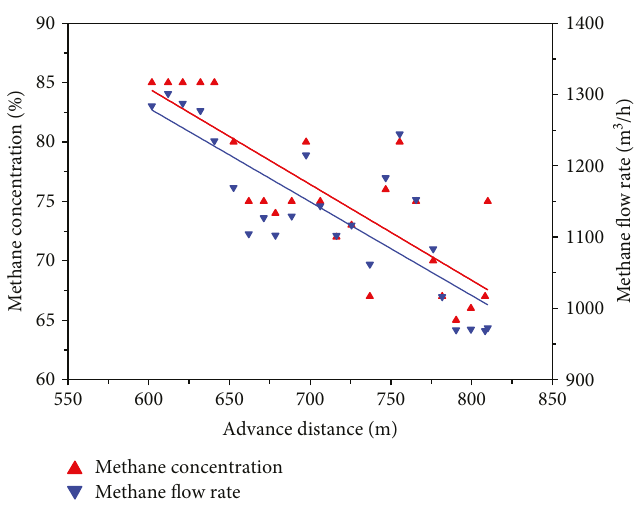
Figure 6: Methane fl ow rate and concentration variations within the MEZ.